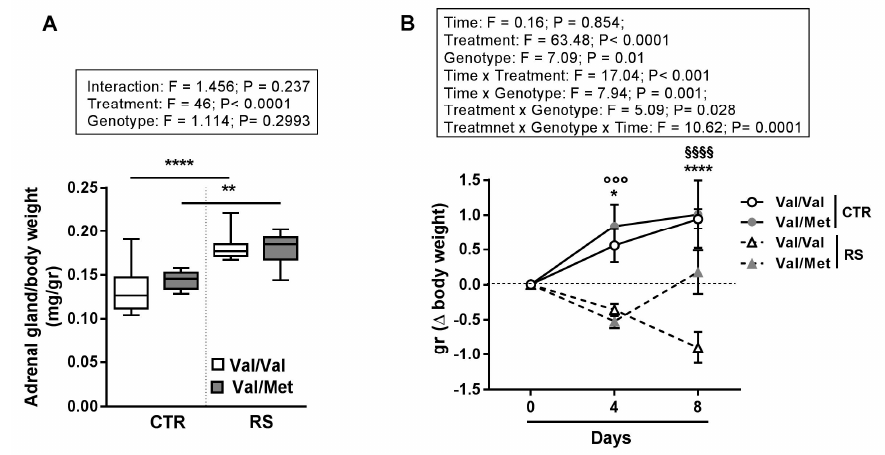
Figure 1. Effect of sub-chronic stress on BDNF Val/Val and BDNF Val/Met mice. Sub-chronic stress was induced by restraint stress (RS) treatment for 7 days, 2 h/day. ( A ) Adrenal gland weight to body weight ratio ( B ) Delta ( Δ ) body weight of mice at day 4 and day 8 of stressed (RS) and not stressed (CTR) BDNF Val/Val and BDNF Val/Met mice. Data are expressed as mean ± SEM. n = 8 mice/group. Two-way ANOVA and three-way ANOVA with repeated measures followed by Bonferroni post hoc analysis, p values were obtained by using log-transformed variables. * p < 0.05, ** p < 0.01, **** p < 0.005 BDNF Val/Val (CTR) vs. BDNF Val/Val stressed (RS) mice, °°° p < 0.005 BDNF Val/Met (CTR) vs. BDNF Val/Met stressed (RS) mice and §§§§ p < 0.00015 BDNF Val/Val stressed (RS) vs. BDNF Val/Met stressed (RS) mice. For each box-plot, the center line illustrates the median and box limits indicate the 25th and 75th percentiles.